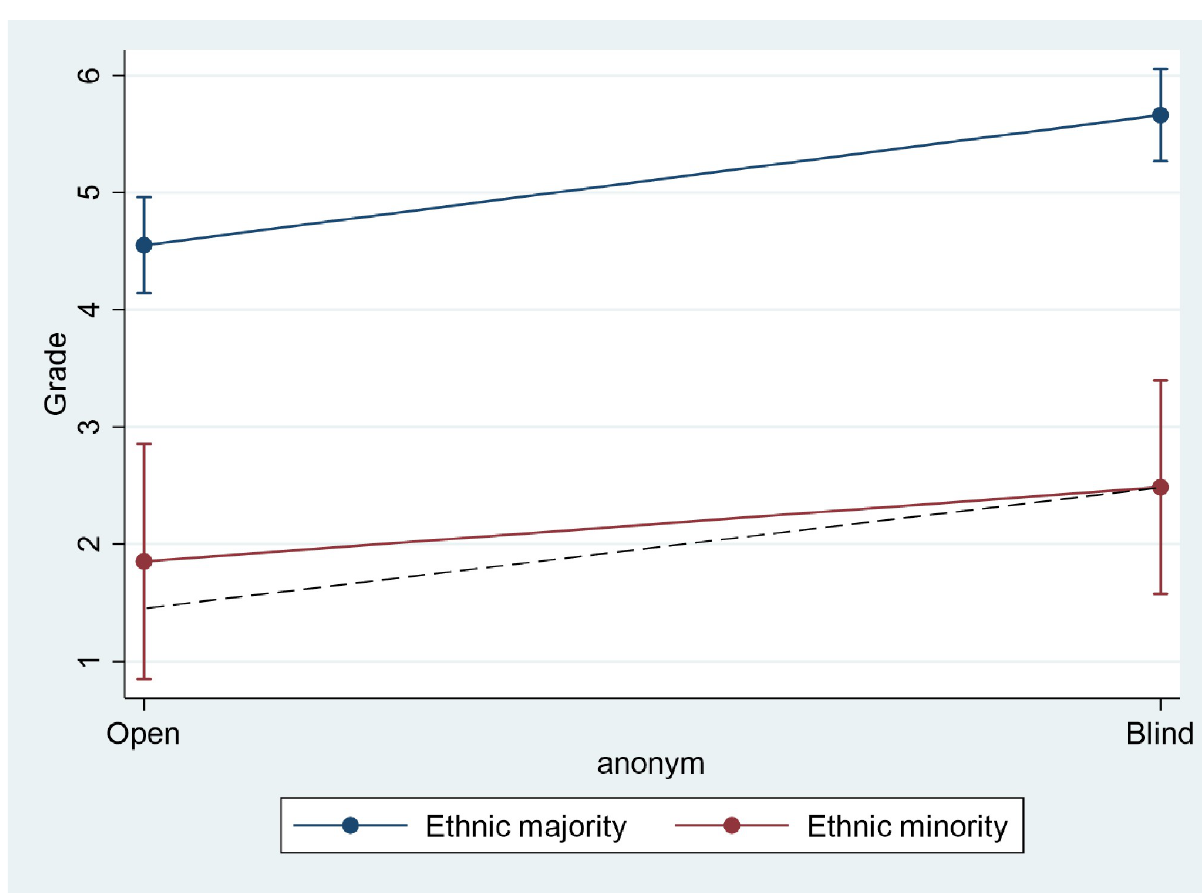
Fig 2. Ethnic bias. The dashed line represents the predicted grades of students with ethnic names with no ethnic bias.